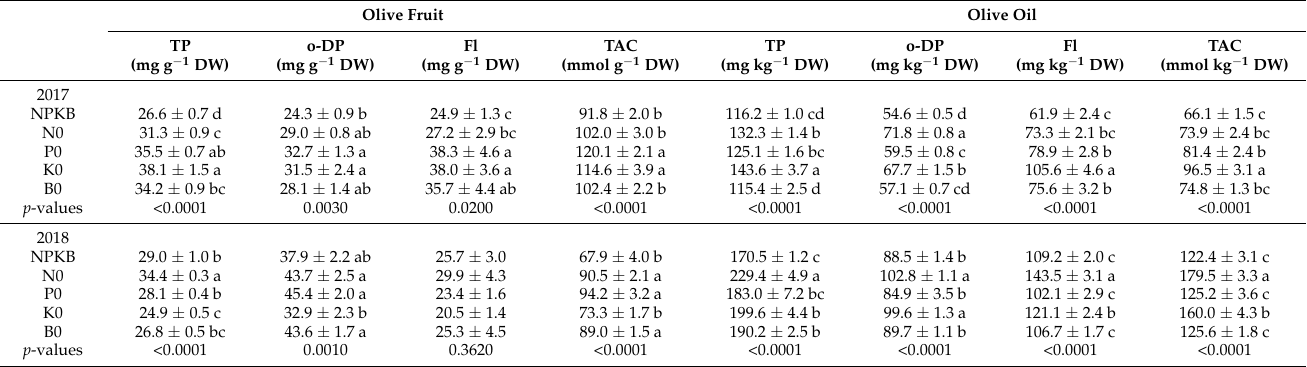
Table 4. Total phenols (TP), ortho-diphenols (o-DP), flavonoids (Fl) and total antioxidant capacity (TAC) on olives and olive oil from olive trees supplied with NPKB (control) and without N (N0), P (P0), K (K0) and B (B0) in the harvests of 2017 and 2018. Olive Fruit Olive